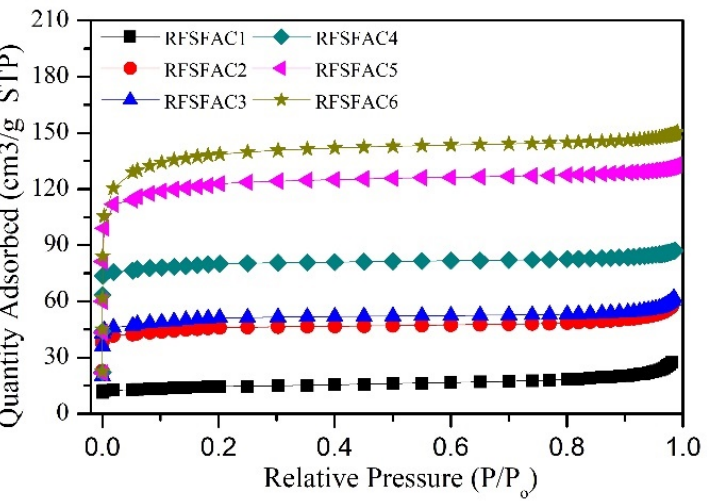
Figure 5. Nitrogen desorption isotherms for RFSFACs prepared with different activating agents and impregnation ratios.